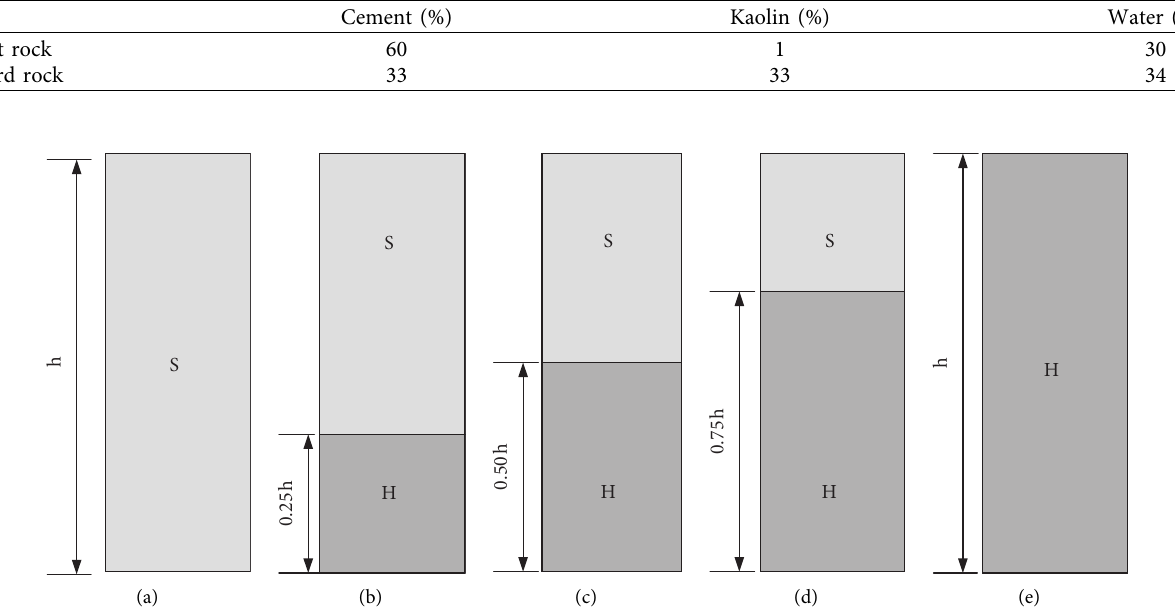
Figure 1: Sketch of the poured model of the composite specimen: (a) soft, (b) 25% hard, (c) 50% hard, (d) 75% hard, and (e) hard.